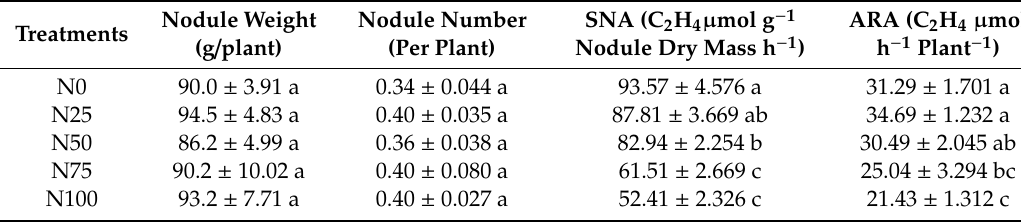
Table 3. Change in ARA and SNA of short-term of experiment